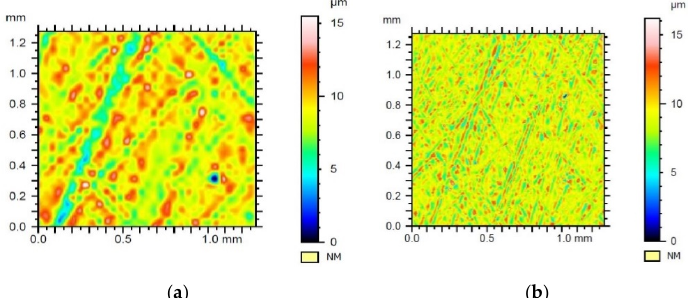
wavelet of the 6th row with the 1st level of filtration—( a ) waviness, ( b ) roughness.